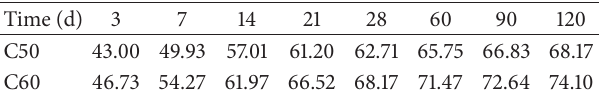
Table 2: The cubic compressive strength of HPC at different ages (MPa).